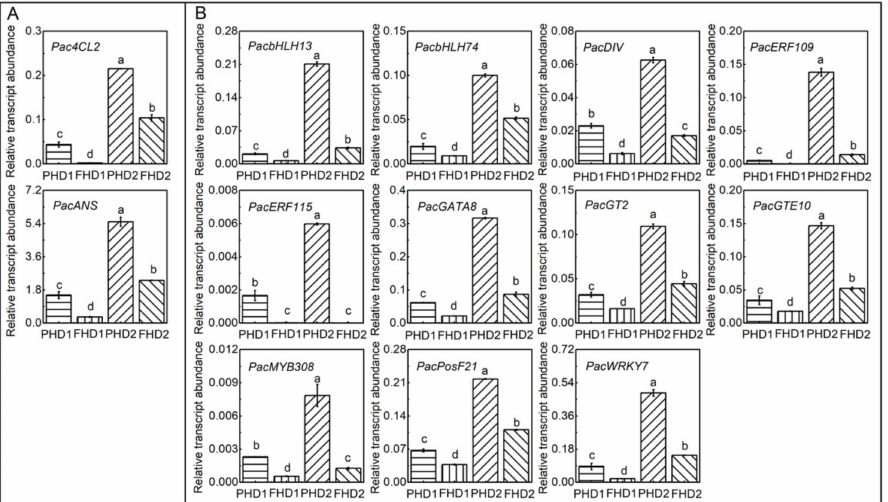
Figure 5. Expression of putative anthocyanin biosynthetic genes during ‘Hong Deng’ development and in different parts, as evaluated by real-time PCR. ( A ) Gene expression of two structure genes. ( B ) Gene expression of 11 transcription factors. Error bars represent SEs from three replicates. The different letters above each column indicate significance at p < 0.05 according to Tukey’s test.